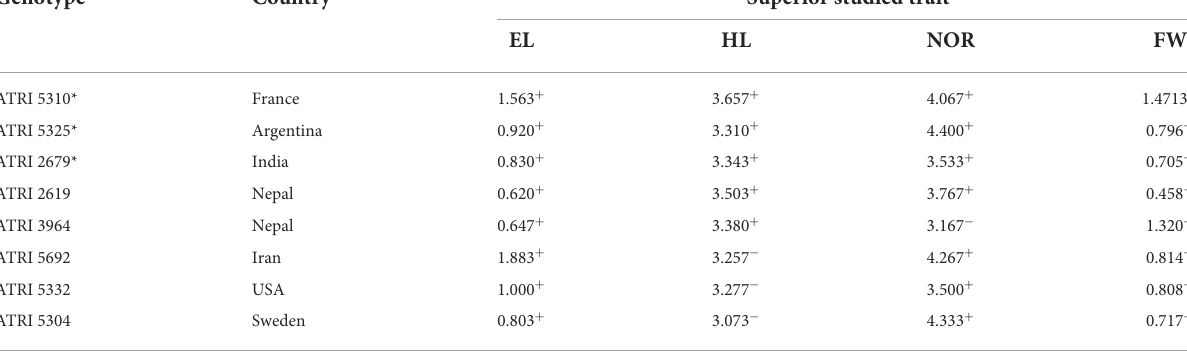
TABLE 4 List of superior genotypes based on at least three out of the four studied traits, Epicotyl length (EL) and Hypocotyl length (HL), number of roots (NOR), and fresh weight (FW).